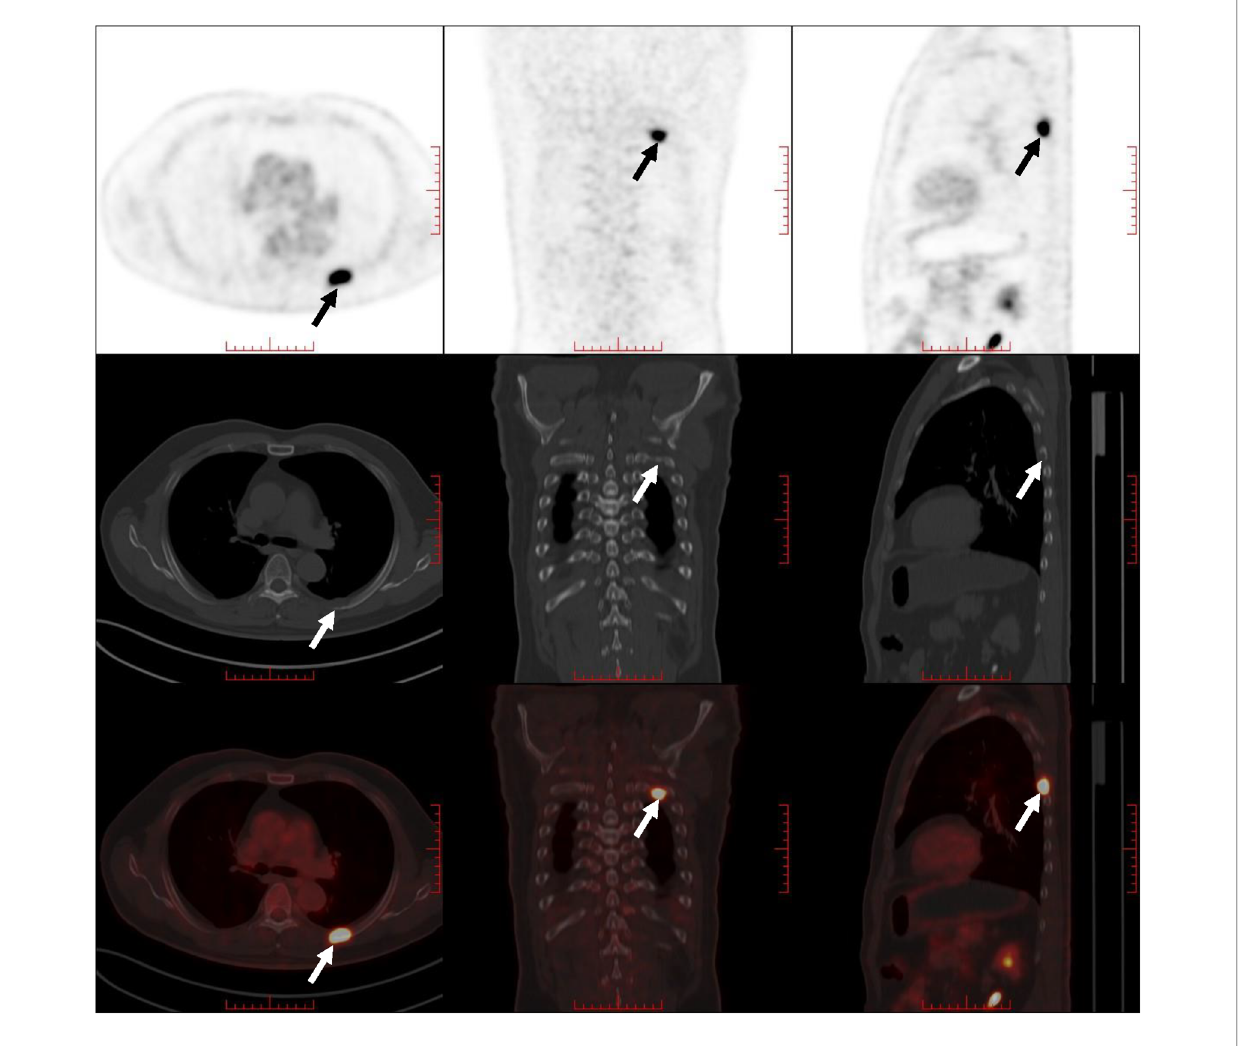
FIGURE 2 PET/CT image showed obvious osteolytic bone destruction and abnormal FDG uptake in the right fi fth rib with local soft tissue mass formation (indicated by